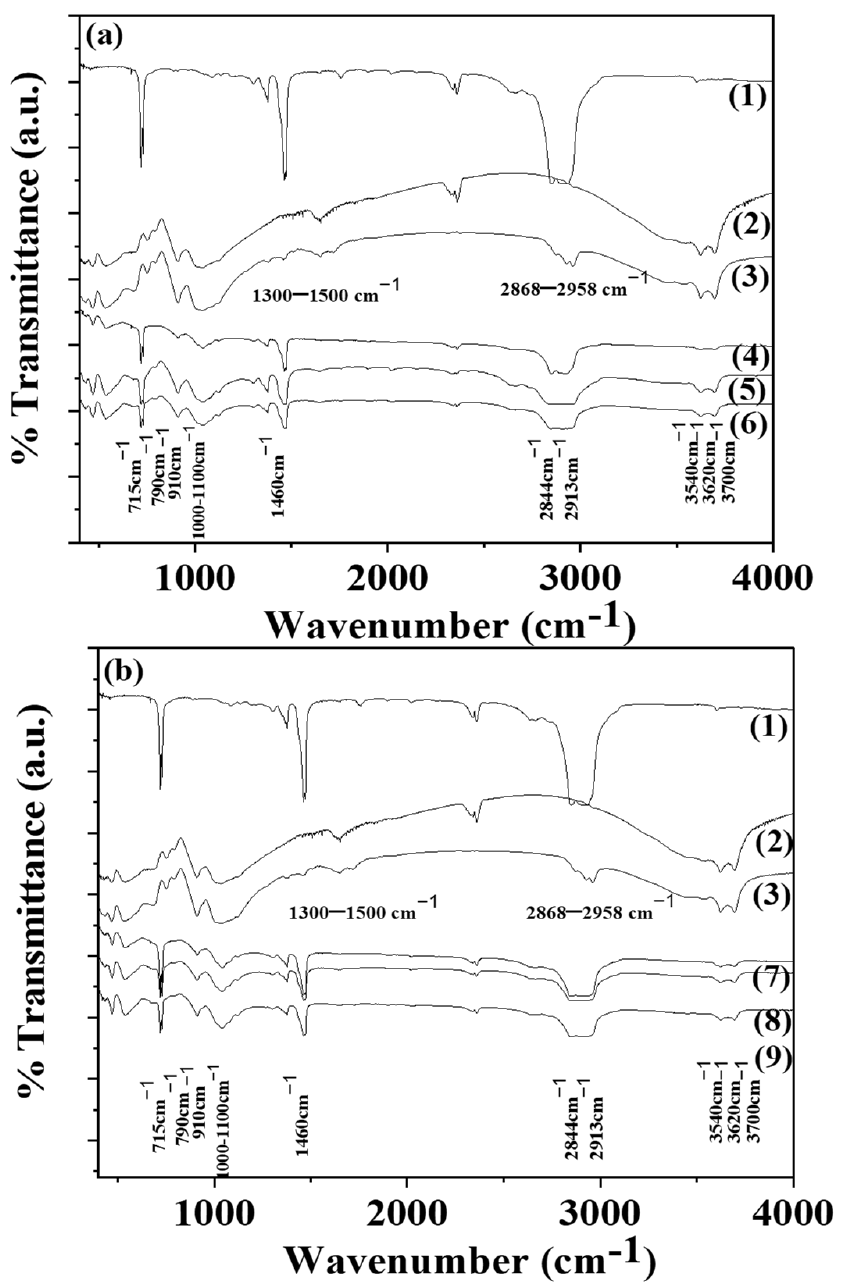
Figure 3. ( a ) FTIR plots of (1) pure LDPE, (2) pure HNT, (3) TO@HNT hybrid nanostructure, (4) LDPE/5HNT, (5) LDPE/10HNT, and (6) LDPE/15HNT films, ( b ) FTIR plots of (1) pure LDPE, (2) pure HNT, (3) TO@HNT hybrid nanostructure, (7) LDPE/5TO@HNT, (8) LDPE/10TO@HNT, and (9) LDPE/15TO@HNT.